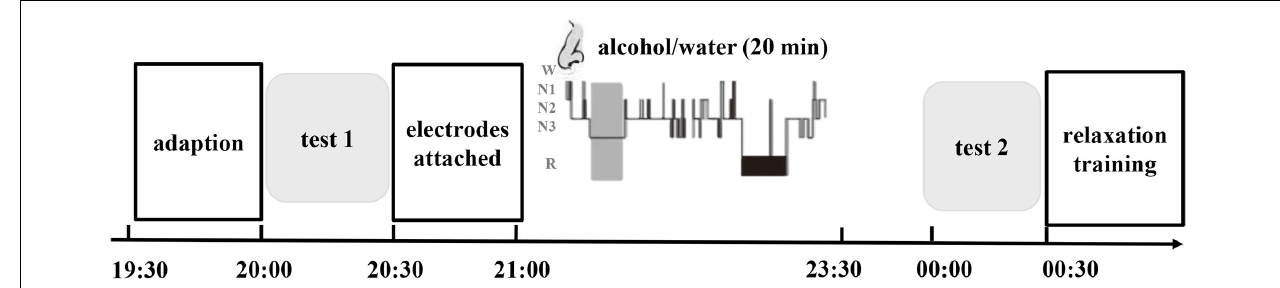
FIGURE 2 | Timeline of the experimental methods. The experimental protocol consisted of three phases: the baseline cue-reactivity test (test 1), extinction during sleep and recall test (test 2). A 2.5-h interval of nocturnal sleep between the initial test and later retesting was allowed. During the first stable NREM sleep period, one group was re-exposed to olfactory alcohol cues (CS group), and the other group was re-exposed to water as an olfactory control (CtrS group). The light gray areas represent the cue reactivity test, and the dark gray area represents the first period of NREM sleep when the odor stimulus was delivered.